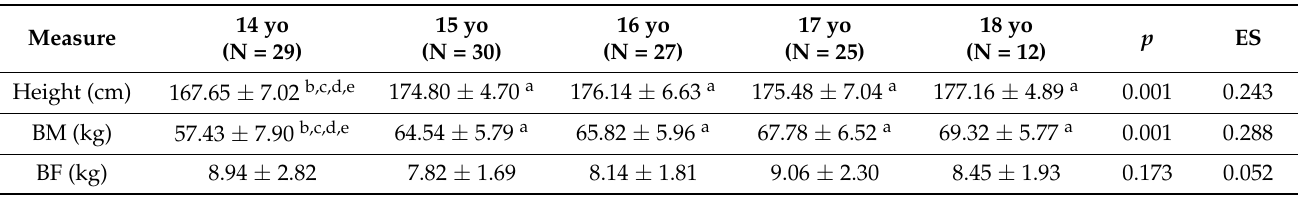
Table 1. Descriptive statistics (mean and standard deviation) for the anthropometric outcomes between age-groups.